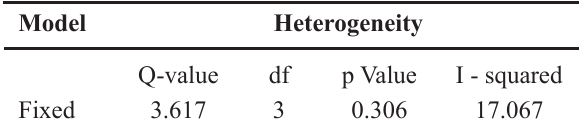
Table 2 – Heterogeneity of studies.